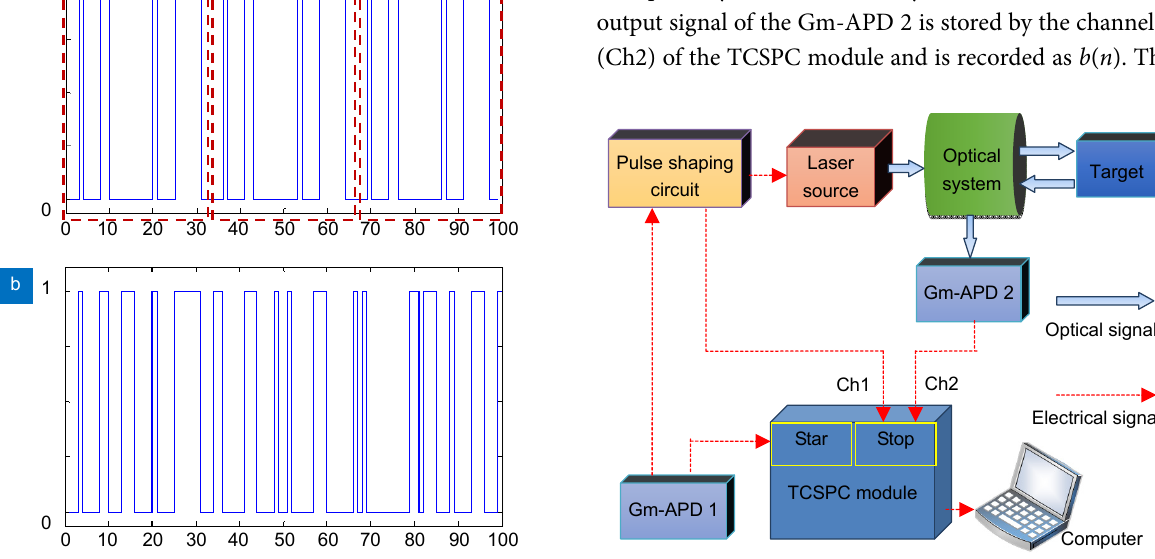
Fig. 2 | True random coded photon counting Lidar system. Fig.1 | (a) Pseudo-random sequence and (b) true random se-